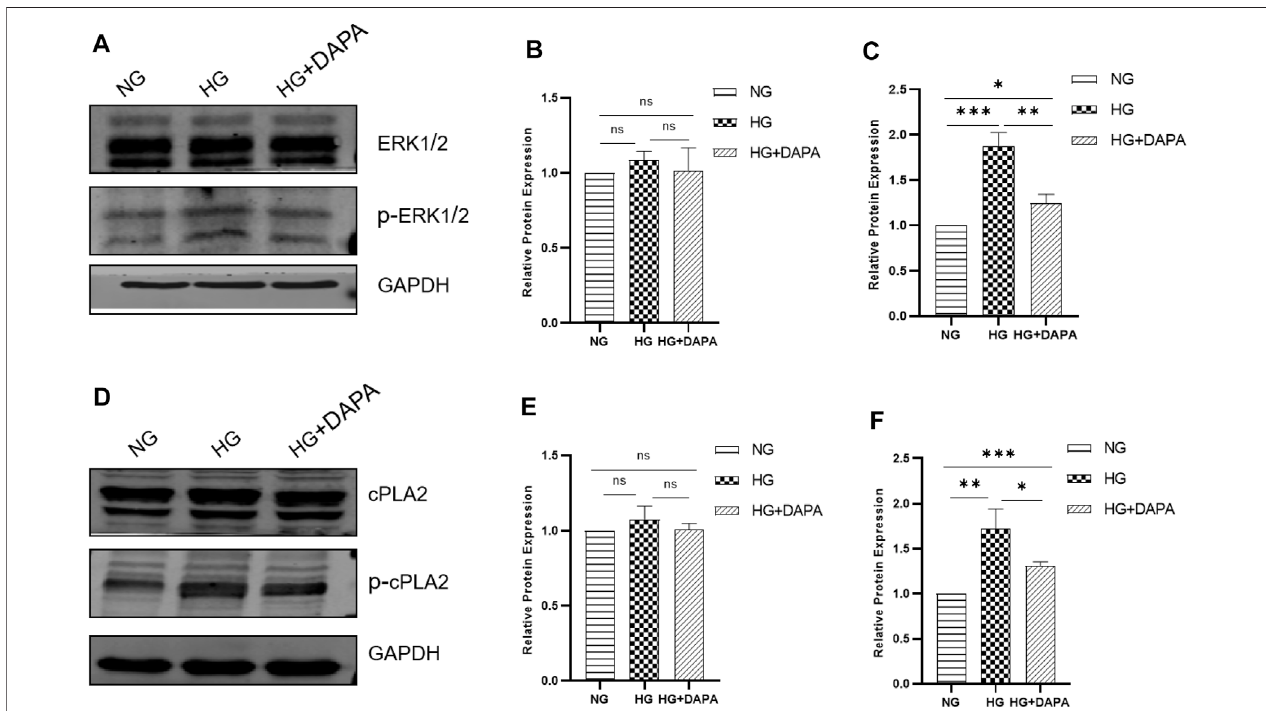
FIGURE 6 | Effect of DAPA on Activity of ERK1/2/cPLA2. (A – C) Determination of the effect of DAPA on the activity of ERK1/2 and p-ERK1/2 in HMRECs by WB. (D – F) Determination of the effect of DAPA on the activity of cPLA2 and p-cPLA2 in HMRECs by WB. Data are presented as means ± SD. * p < 0.05, ** p < 0.01, *** p <